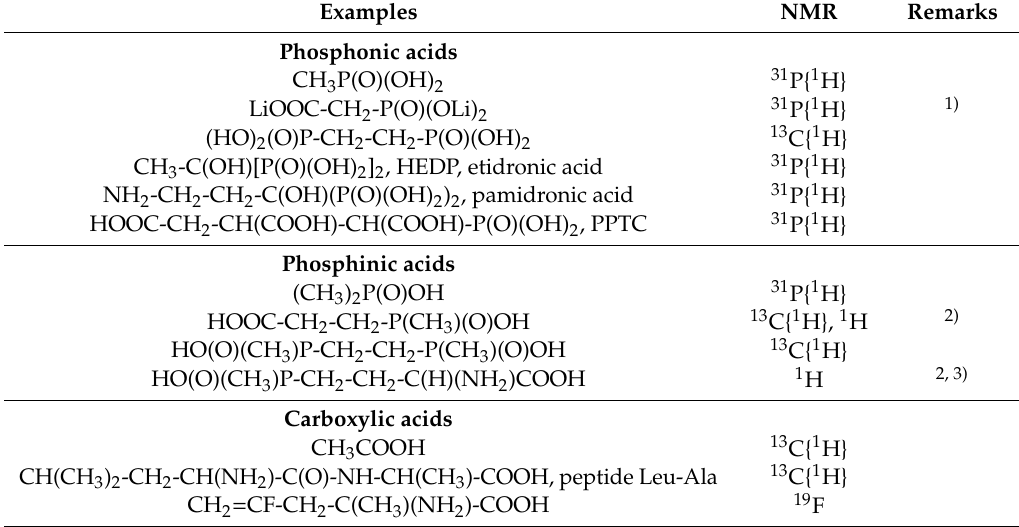
Table 1. Some examples for NMR-controlled titrations of phosphonic acids, phosphinic acids, and carboxylic acids as discussed in [32]. 1) Retro titration; 2) Micro dissociation; 3) Second-order 1 H-NMR spin